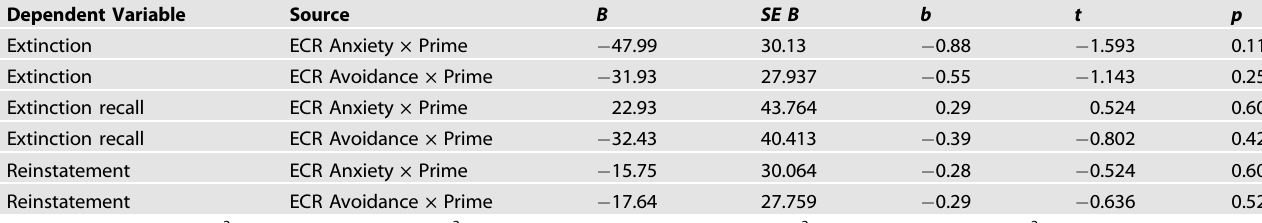
Table 2. Moderation analyses on attachment